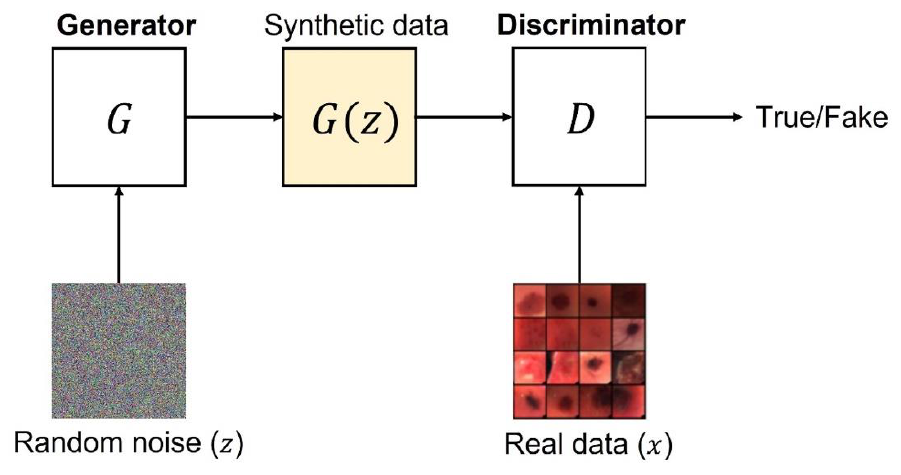
Figure 2. GAN standard structure.